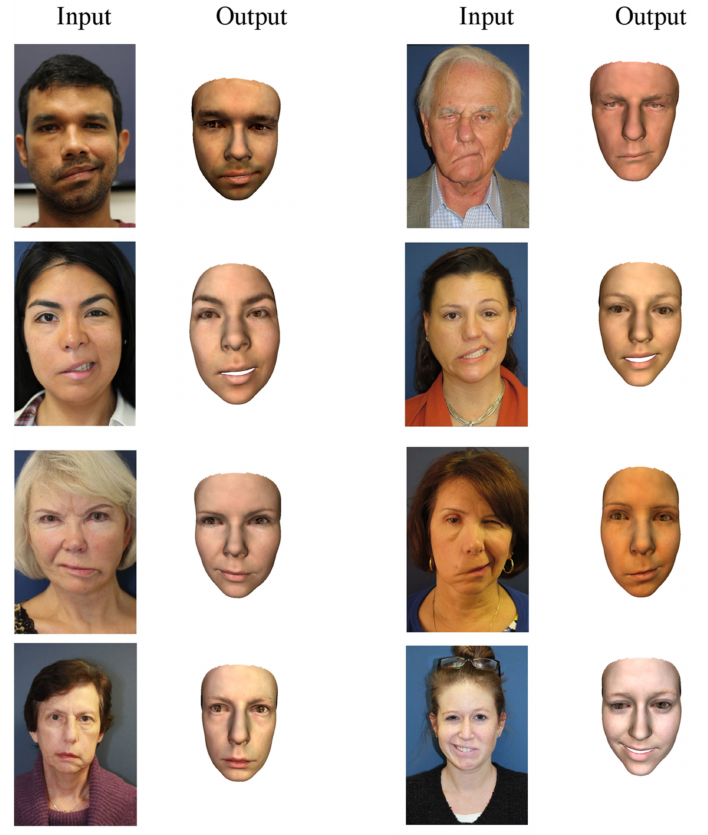
Figure 13. The 3D face reconstruction of facial palsy patients using method 3 (deep 3D face recon- struction) using collected images in open access